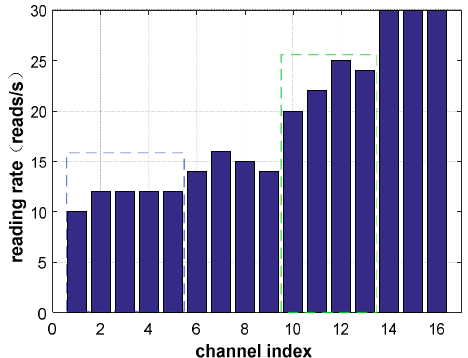
Figure 1. A typical example of channel correlation.